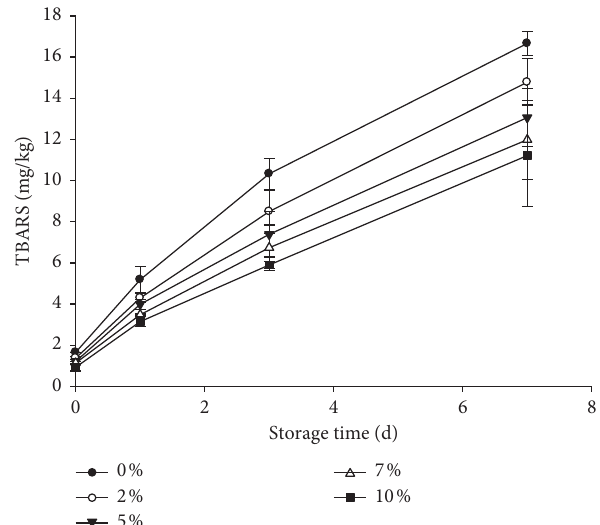
Figure 2: Oxidation stability of emulsified sausages with different ratios of fat replacement using FWGE during 7 days of storage at 4 °